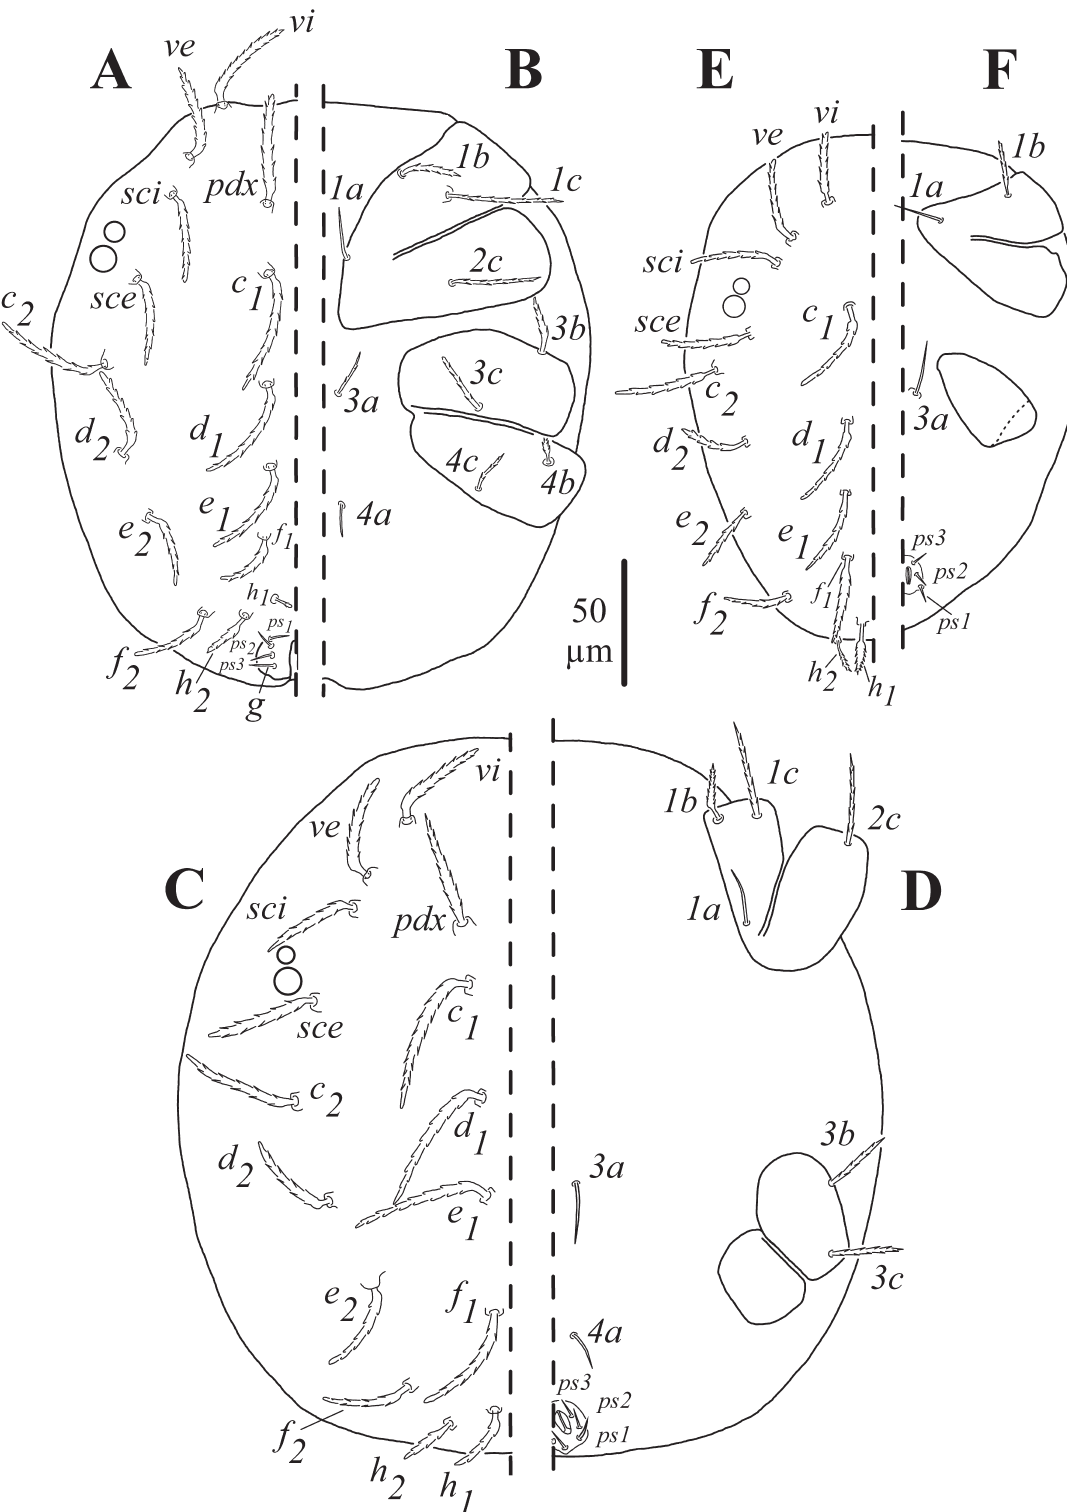
Fig. 2. Neophyllobius cibyci sp. nov. A–B . ♂, paratype (CNAC009238). A . Dorsal idiosoma. B . Ventral idiosoma. C–D . Protonymph, paratype (CNAC009241). C . Dorsal idiosoma. D . Ventral idiosoma. E–F . Larva, paratype (CNAC009242). E . Dorsal idiosoma. F . Ventral